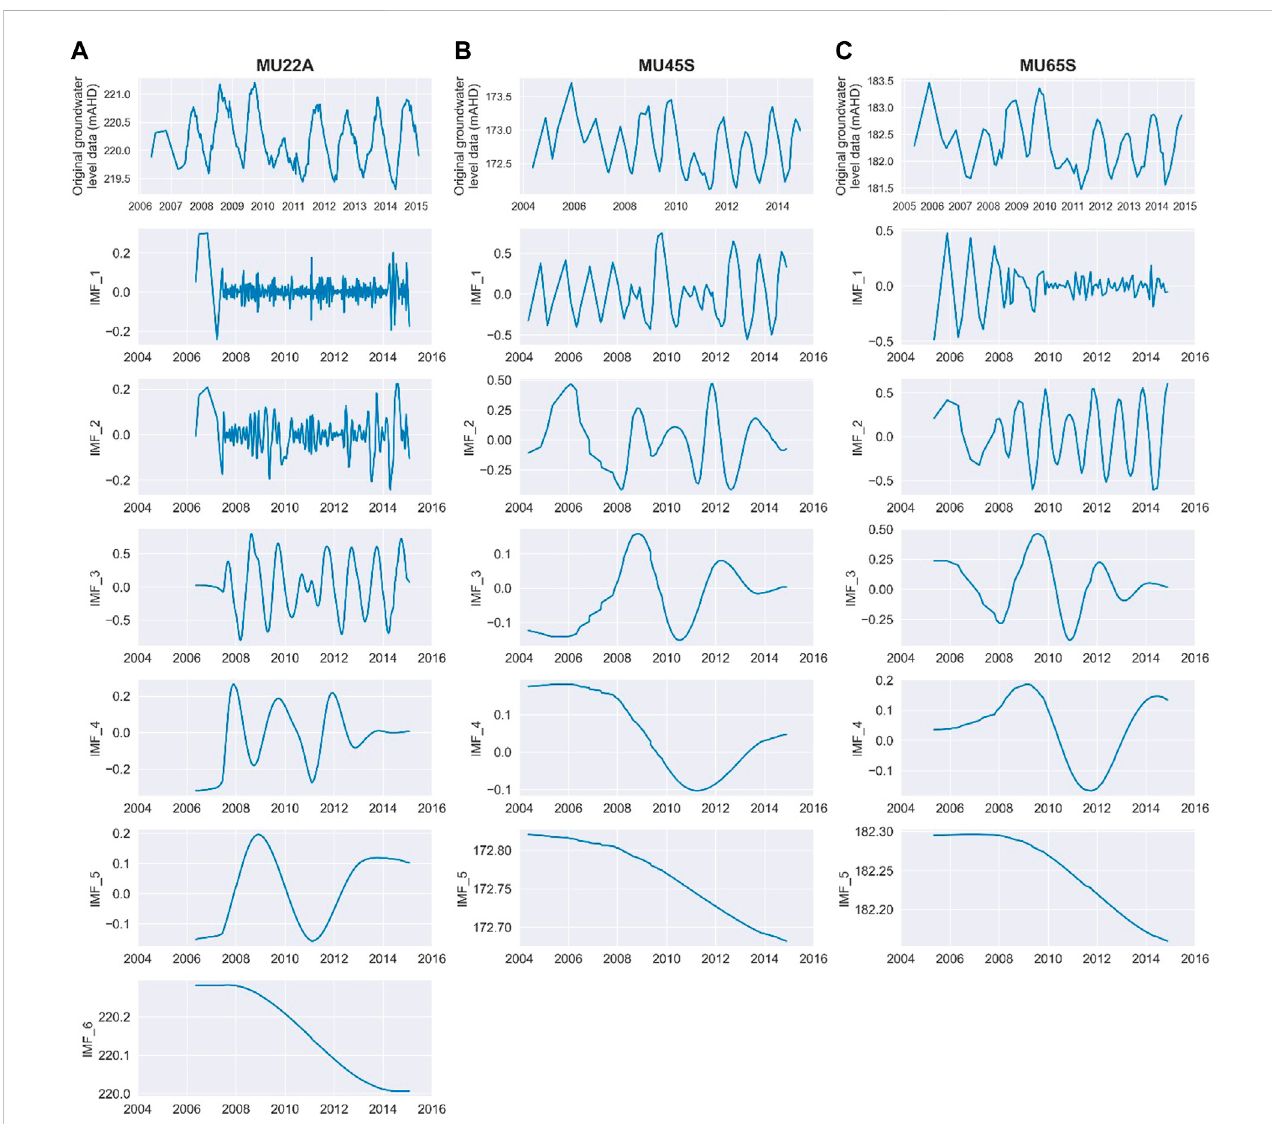
FIGURE 7 Historical groundwater levels and Intrinsic Mode Functions obtained from the EMD analysis for boreholes MU22A (A) , MU45S (B) and MU65S (C) .